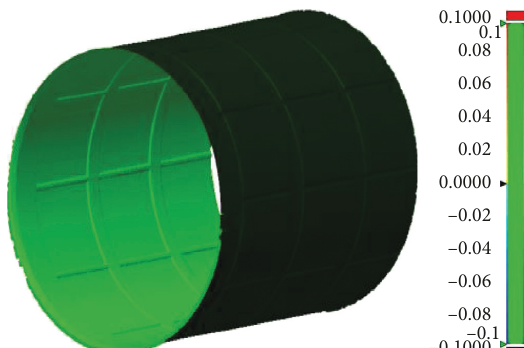
Figure 25: 3D deviation analysis of sample with a rib height of 2.5